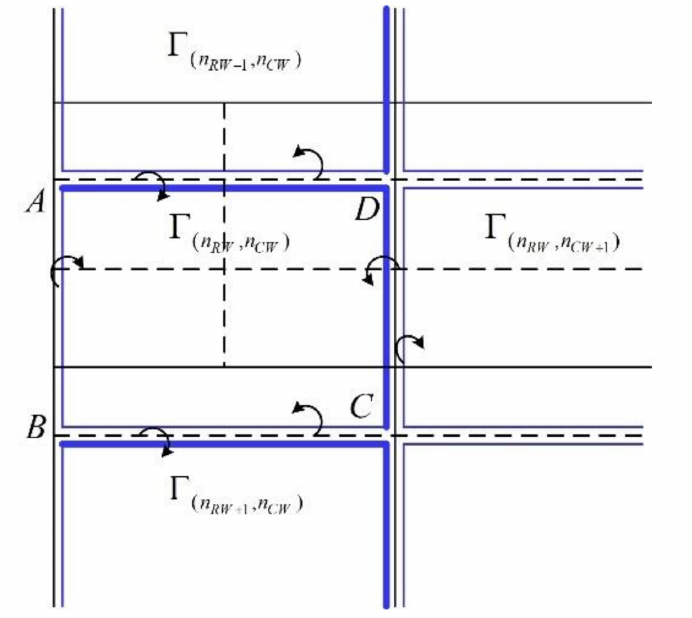
Figure 6. The circulation of neighboring